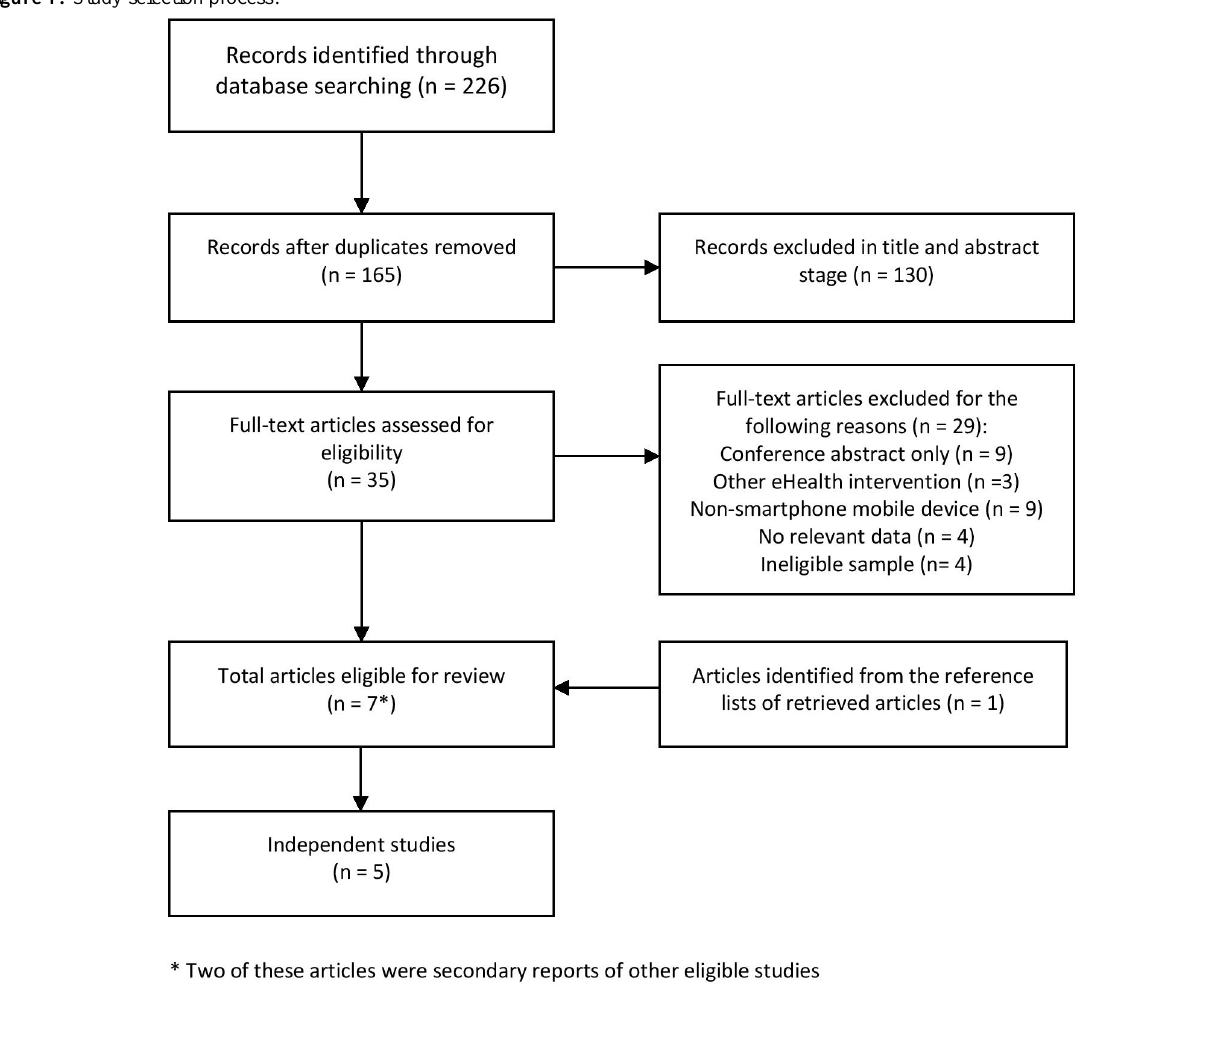
Figure 1. Study selection